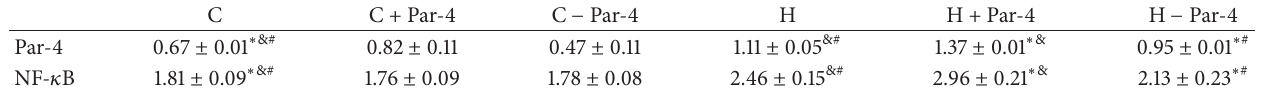
Table 3: The nuclear protein expression of Par-4 and NF- 𝜅 B of each group. C C + Par-4 C −